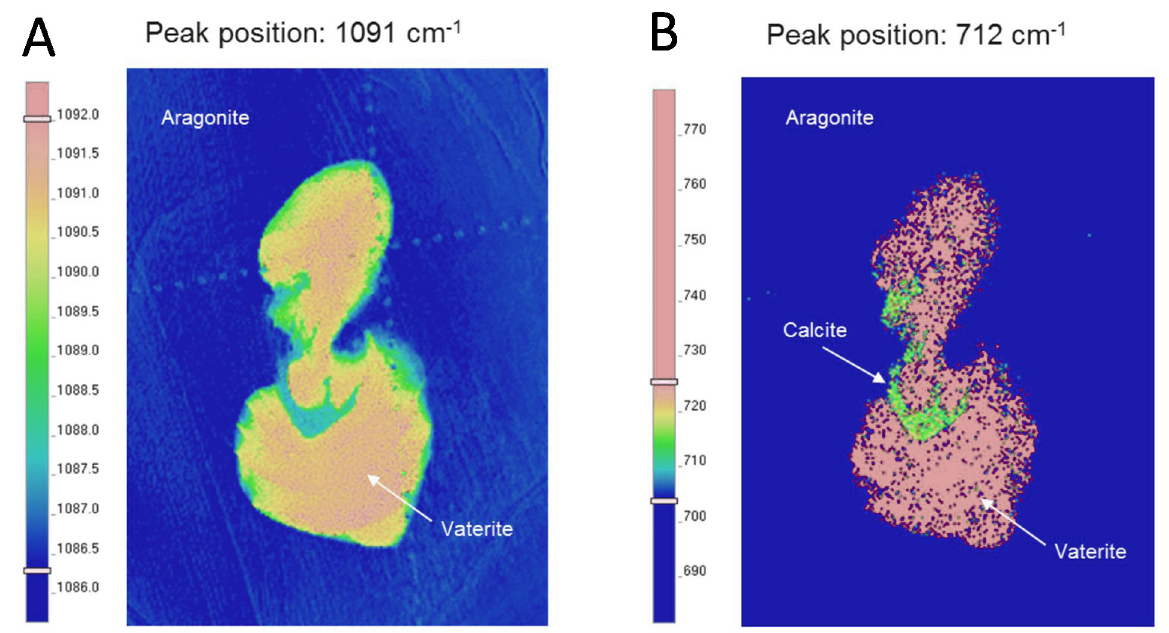
Figure 32. Raman maps collected using the 785 nm laser at room temperature showed intensity variation of the vaterite band at 1091 cm − 1 ( A ) and the calcite band at 712 cm − 1 ( B ). Raman map at 1091 cm − 1 peak position showed high intensities of vaterite zone in the center and enclosing with low intensities (dark blue) of aragonite area. Calcite was clearly indicated with 712 cm − 1 peak position as an irregular small area (green intensity) associated with vaterite in the center.